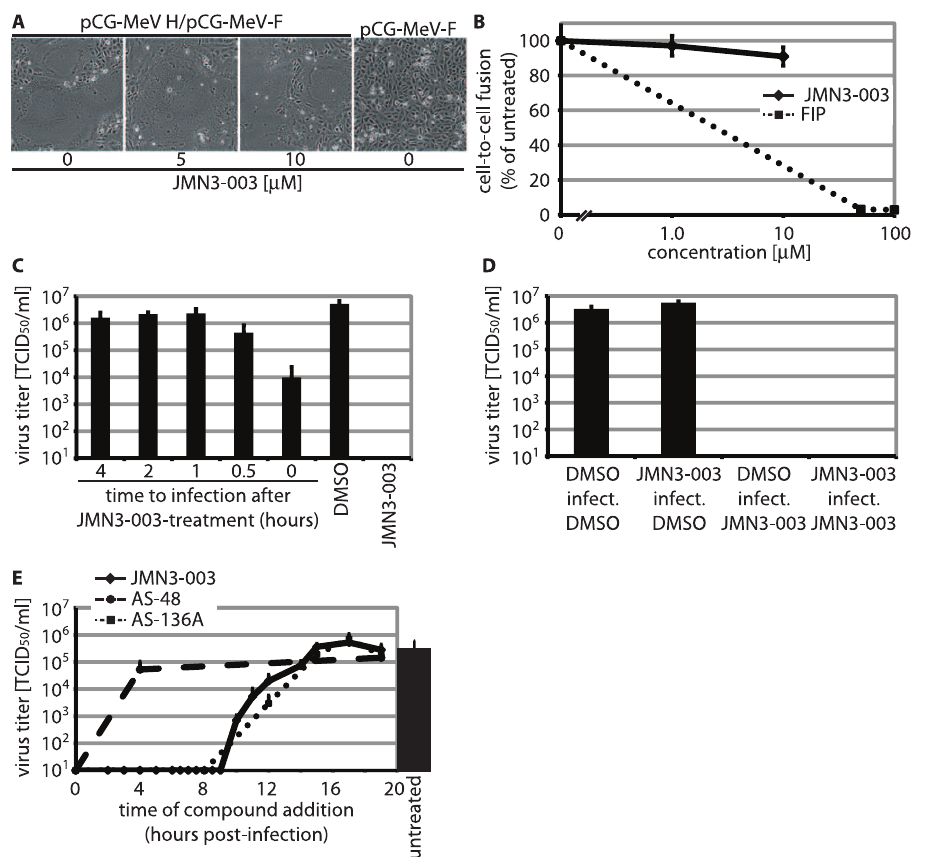
Figure 6. In time-of-addition assays, JMN3-003 shows the inhibition profile of an RdRp blocker. A–B ) Cell-to-cell fusion is unaffected by the compound. Microphotographs of MeV-H and F expressing Vero-Slam cells ( A ) and quantitative cell-to-cell fusion assays ( B ) show membrane fusion activities in the presence of JMN3-003 similar to those observed for vehicle (DMSO)-treated controls. The effect of fusion inhibitory peptide (FIP) is shown in (B) for comparison. C ) JMN3-003 antiviral activity is reversible and not based on cell priming. Vero-Slam cells were pre-treated with 1.0 m M JMN3-003 for 60 minutes, followed by compound wash-out and incubation for the indicated time periods; at t 0 , cells were infected with MeV- Alaska. D ) JMN3-003 lacks virucidal activity. MeV-Alaska particles were incubated with 1.0 m M JMN3-003 for 60 minutes, followed by dilution of compound to 1.0 nM and infection of cells at an MOI of 0.033 in the presence of vehicle (JMN3-003/infect./DMSO). Equally treated controls received vehicle only (DMSO/infect./DMSO), compound only after infection (DMSO/infect./JMN3-003), or compound for the duration of the experiment (JMN3- 003/infect./JMN3-003). E ) Addition of JMN3-003 (1.0 m M final concentration) at the indicated times post-infection of cells with MeV-Alaska. For comparison, inhibition profiles of the MeV entry inhibitor AS-48 (75 m M) and RdRp blocker AS-136A (25 m M) are shown. Controls received vehicle only (DMSO) at the time of infection. For (C–E), values show titers of cell associated viral particles (TCID 50 /ml) and represent averages of at least three experiments 6